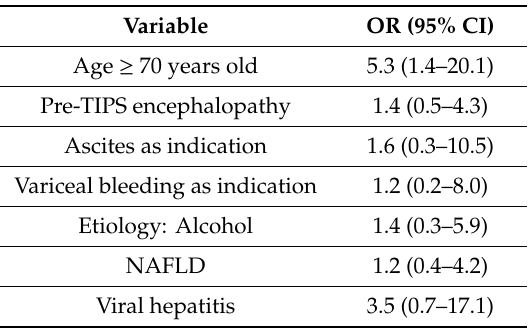
Table 5. Results of multivariable analysis for